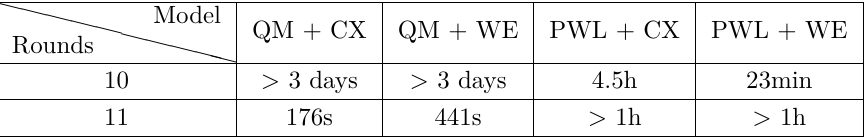
Table 11: Solving times for CLEFIA over 10 and 11 rounds depending on the